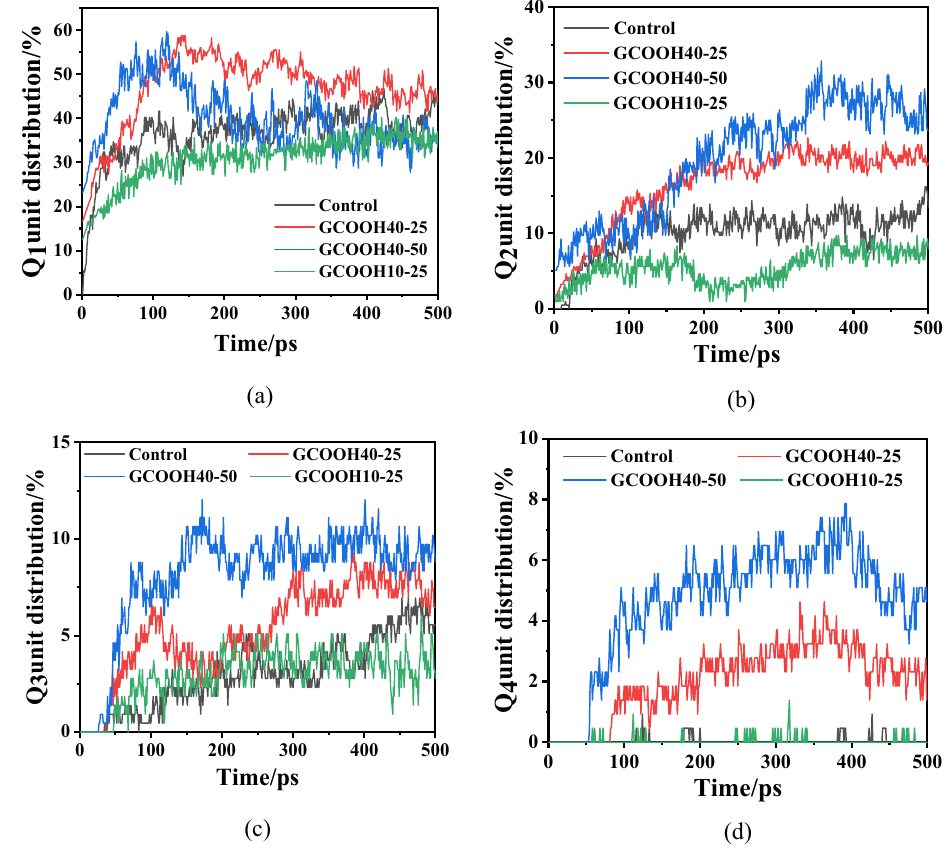
Figure 5: Variation curves of Q n content. ( a ) Q 1 , ( b ) Q 2 , ( c ) Q 3 , and ( d ) Q 4 .